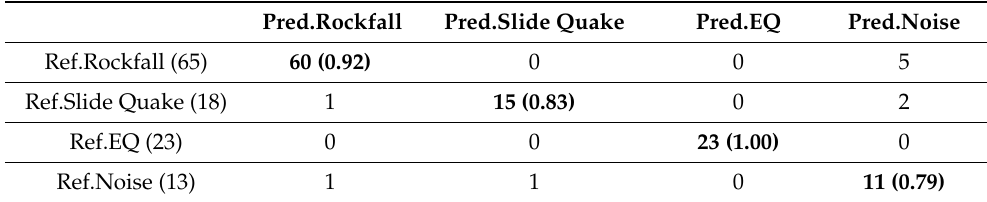
Table 6. Classification results of the cataloged events in [12] from continuous data a